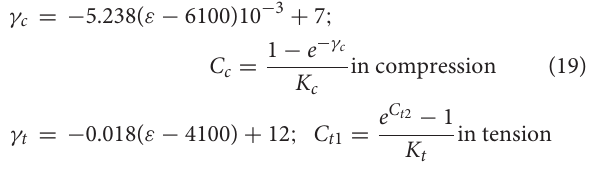
In the damage model proposed by Martínez-Reina et al. (2009), cracks were assumed to grow normal to the maximum strain direction and only under tensile strains. This allows to apply the model to a general strain state, by replacing ε with the maximum principal strain, ε max . The tests performed by Pattin et al. (1996) and fitted with Equation (18) were conducted under constant strain. However, they can be applied to a general loading history using the procedure described in Martínez-Reina et al. (2009) and explained